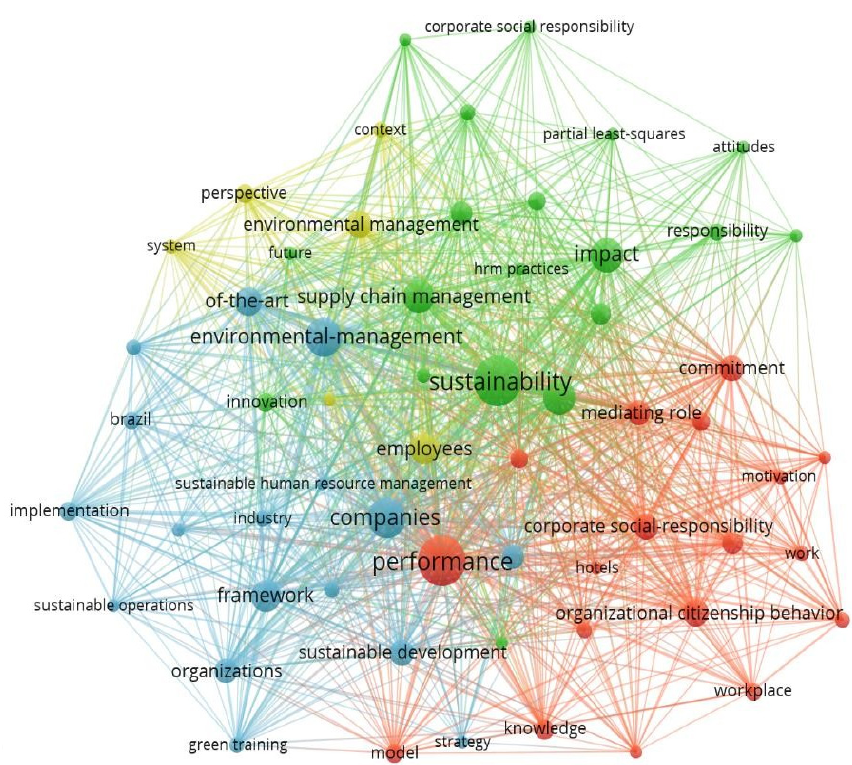
Figure 4. Bibliographic coupling.